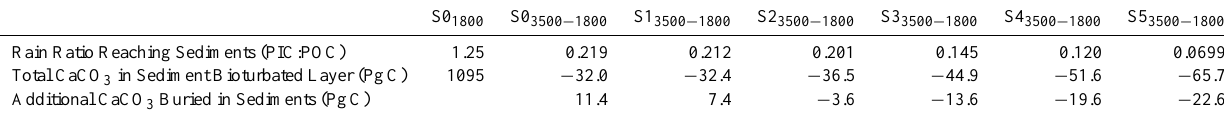
Table 4. Summary of the change in rain ratio and sediment output for years 1800–3500 for Suite S simulations. Values in column S0 1800 represent absolute output in the base model in year 1800. Subsequent columns show differences from 1800 to 3500 for each calcification sensitivity (S0 to S5).